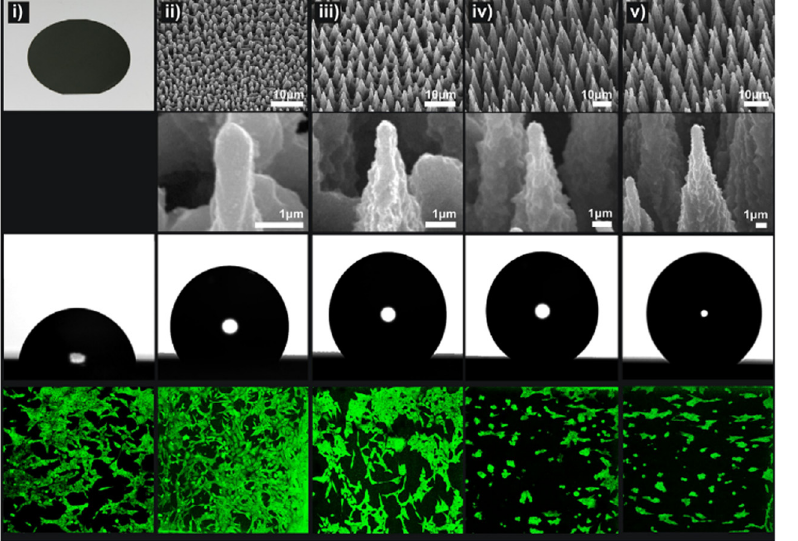
Figure 12: Cell adhesion was regulated by controlling the roughness and wettability of 3D micro/nano silicon structures ( reproduced from ref. [ 99 ])